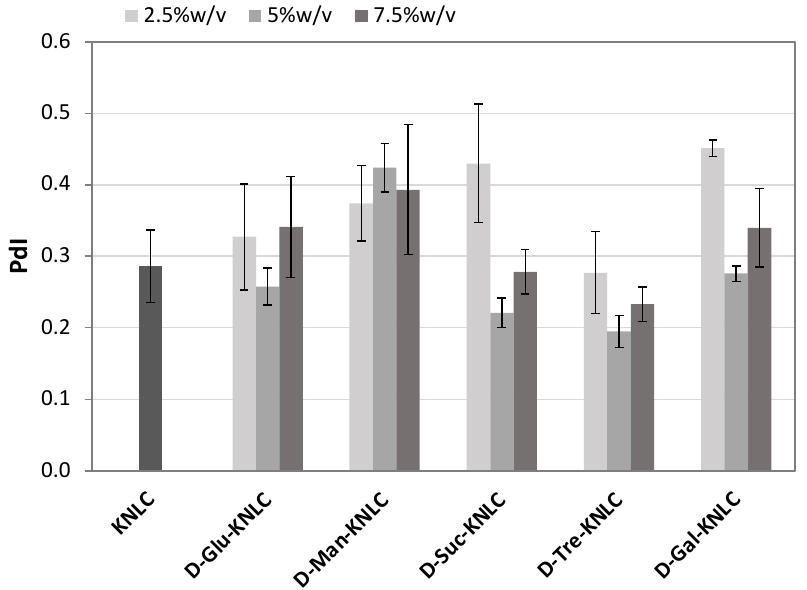
Figure 3. PdI values of K-NLCs and K-NLCs freeze-dried using (2.5, 5, and 7.5)% w/v of different lyoprotectants (D-glucose anhydrous, D-mannitol, D-sucrose, D-trehalose dihydrate, and D-galactose). Data are shown as the mean ± standard deviation ( n = 3).